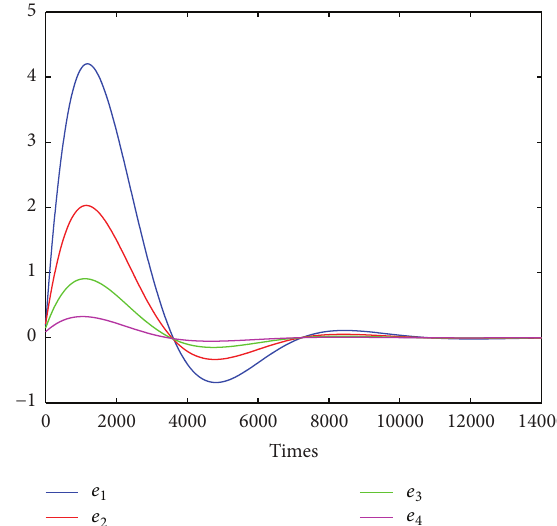
Figure 2: Synchronization errors 𝑒 1 , 𝑒 2 , 𝑒 3 , and 𝑒 4 coupled memris- tor chaotic oscillator systems.